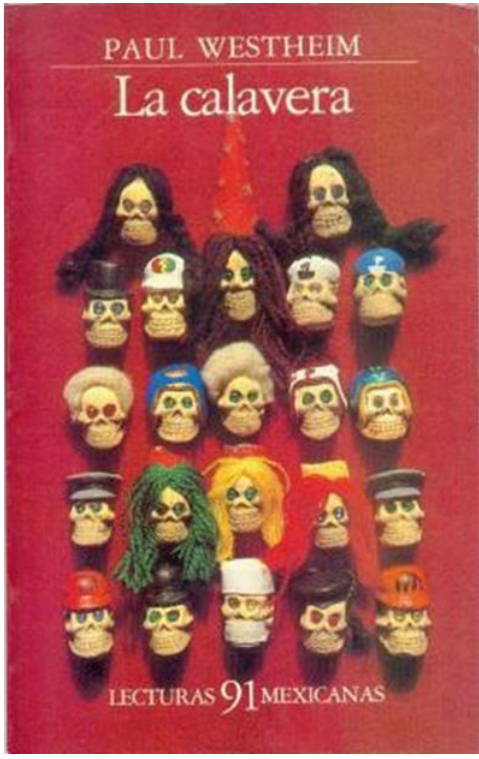
Figure 9: Cover of La Calavera (Westheim 1983) Westheim (1983) posits that Tezcatlipoca is a way into understanding how contemporary Mexicans perceive art as a means of passing down a distinctly Mexican way of dealing with the uncertainty of life, death, and ancestral memory. Through this, Westheim creates a bridge between art history and archaeology as a way to make sense of the lived experience of contemporary Mexicans through visual culture. Elizabeth Baquedano associates Tezcatlipoca, the enigmatic Aztec trickster god and ‘Lord of the Smoking Mirror’ with t he uncertainty of life and ancestral memory, a presence of absence, a shaman- like shadow that “crosses spatial and mythical boundaries with impunity” (2014, 2). Tezcatlipoca is characterised by an obsidian mirror (black volcanic glass) for a leg (Olivier 2015) which, if we are to believe ethno- historical sources, gave its owner perceptual “access to the intangible world of reflections, where souls, spirits, and the immanent forces of the cosmos dwell” (Baquedano 2014, 2); even seeing one’s reflection in the water, watching smoke rise from Popocatépetl volcano, or hearing echoes could all be signs of Tezcatlipoca in the world. Manifested as his animal counterpart, the jaguar, Tezcatlipoca is Tepeyollotl (’Heart of the Mountain’): god of mountains, earthquakes, and echoes. Baquedano (2014) alludes to Tezcatlipoca’s ambiguous and chthonic association to the underworld as a route to understanding the interlocking and ambivalent complexities at play in “Aztec belief and social action across all levels of Late postclassic central Mexican culture” (5). Centring around this anxiety of/for life, Tezcatlipoca manifests in all manner of creative and playful registers in Mexico. Take ex votos or retablos . A Mexican folk art typically painted on tin plates, votive paintings are a way of pictorially expressing stories that might otherwise have remained silent, such as stories of migration (Durand and Massey 1995; Giffords 1974). Other examples of manifestations of Tezcatlipoca include the sweet calaveritas de amaranto (amaranth candy skulls) that families place on ofrendas (offerings) for the day of the dead, mass reproductions of José Guadalupe Posada’s